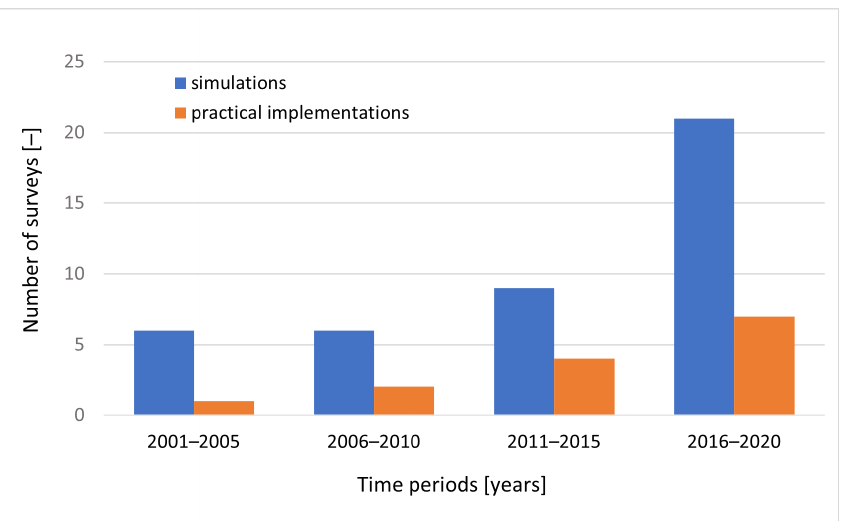
Figure 4. Number of publications in the field of simulation methods and practical implementations of control and collision avoidance systems for AUV in the last 20 years.